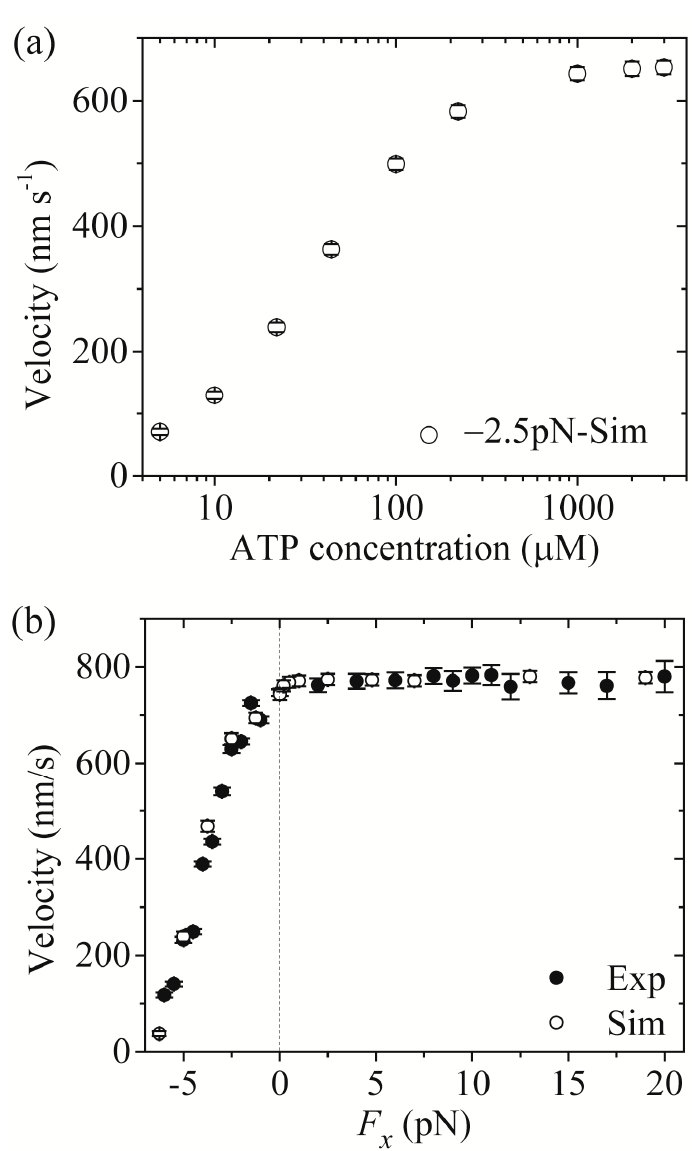
Figure 4. Kinesin-1 velocity as a function of [ATP] and force. Unfilled circles are simulated data, while filled circles are experimental data taken from Andreasson et al. [17]. ( a ) Velocity versus [ATP] at F x = − 2.5 pN. ( b ) Velocity versus F x at [ATP] = 2 mM.